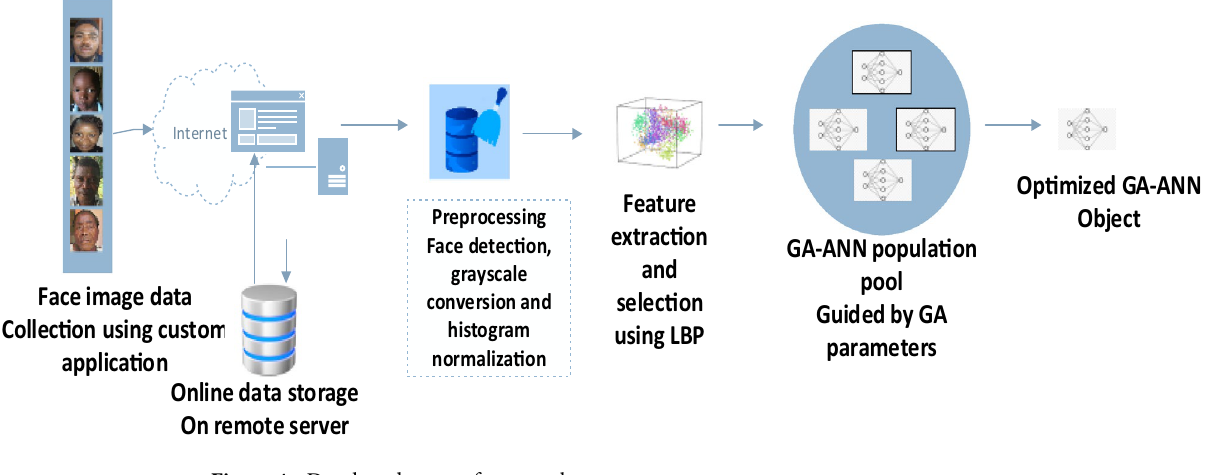
Figure 4. Developed system